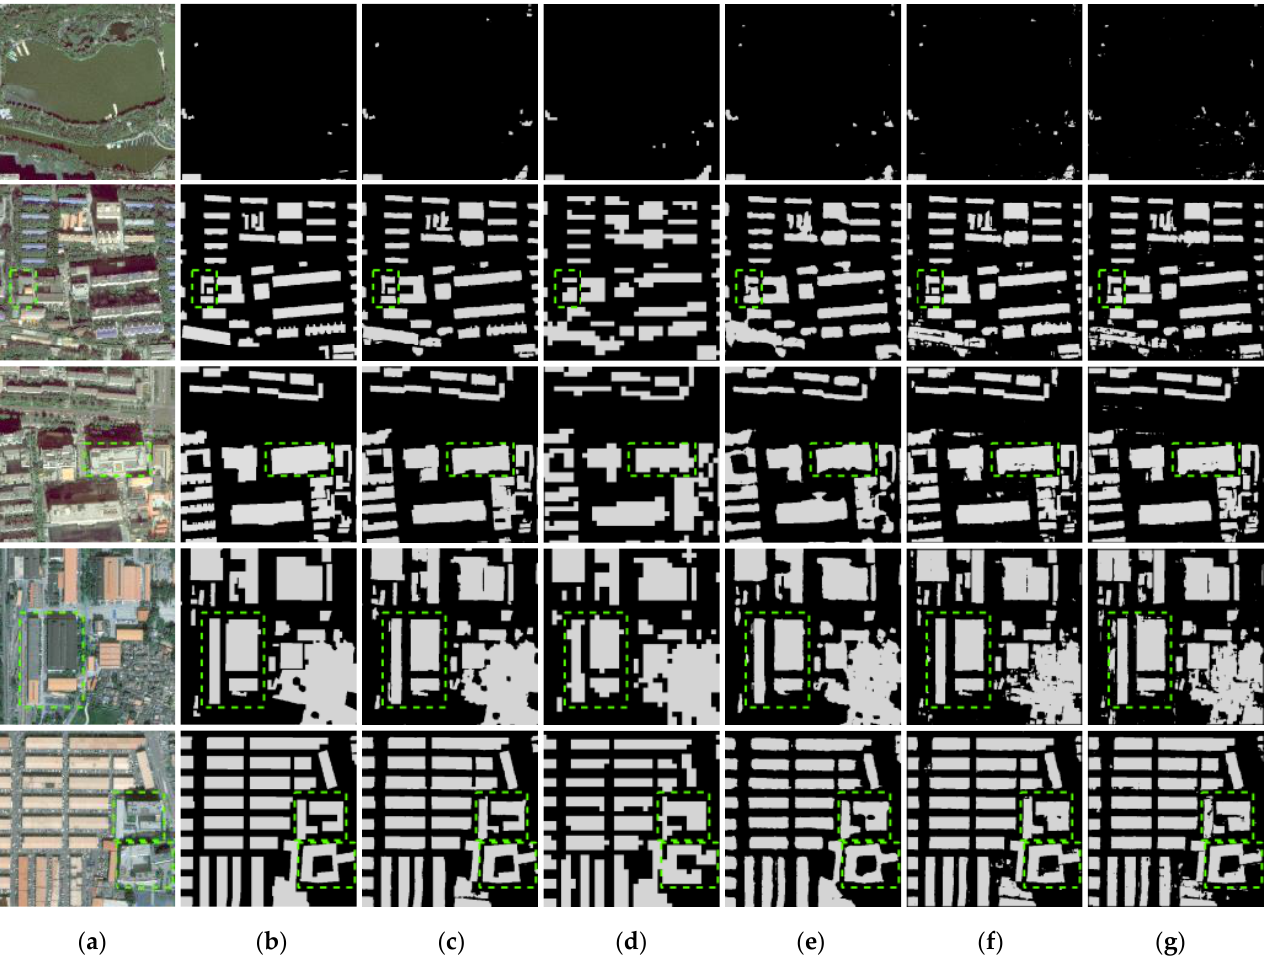
Figure 7. Building extraction results of different models. ( a ) Image ( b ) Label ( c ) DMU-Net ( d ) PSPNet ( e ) DeepLab V3+ ( f ) EU-Net ( g ) Table 2. Building extraction accuracy corresponding to different network structures.